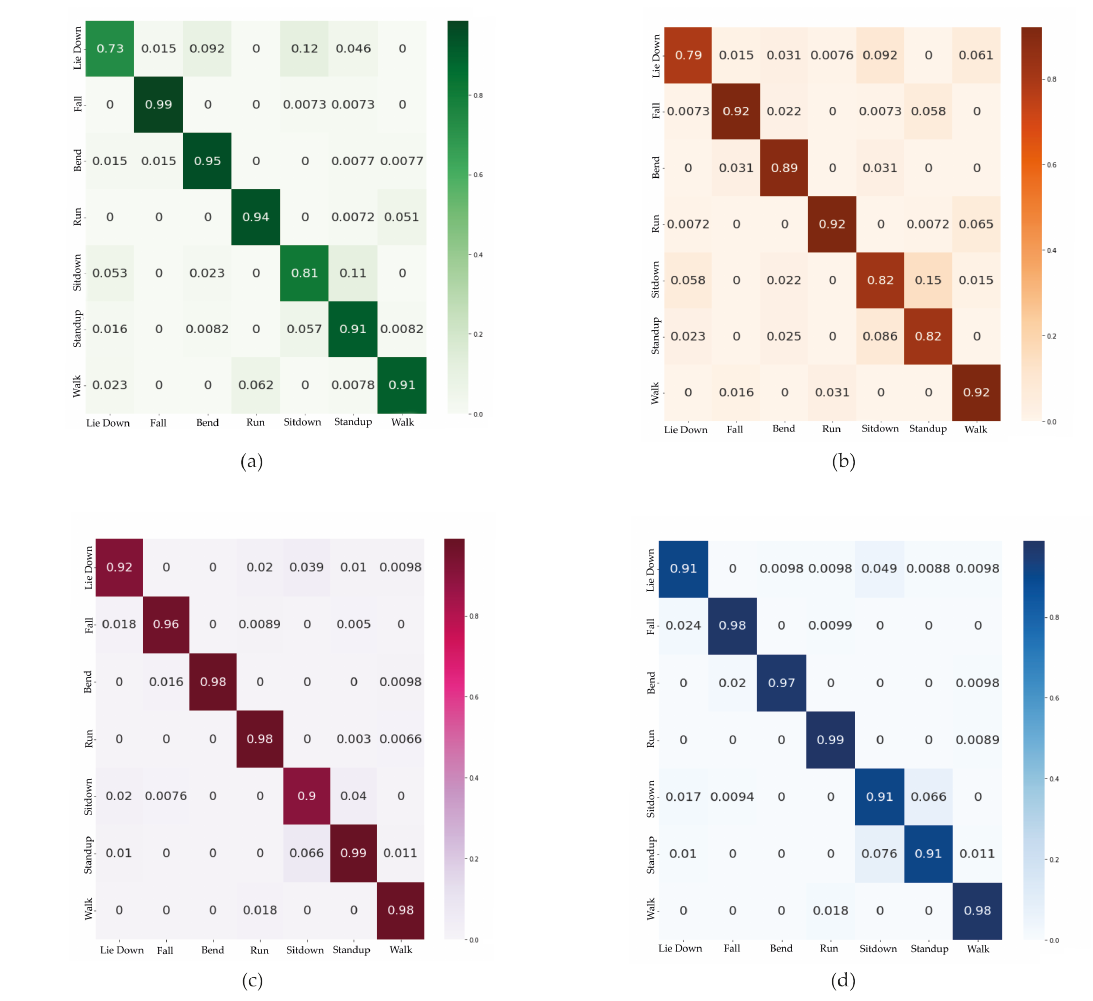
Figure 9. Confusion matrices of proposed methods: ( a ) LSTM; ( b ) 1D-CNN; ( c ) BLSTM; ( d ) 2D-CNN.